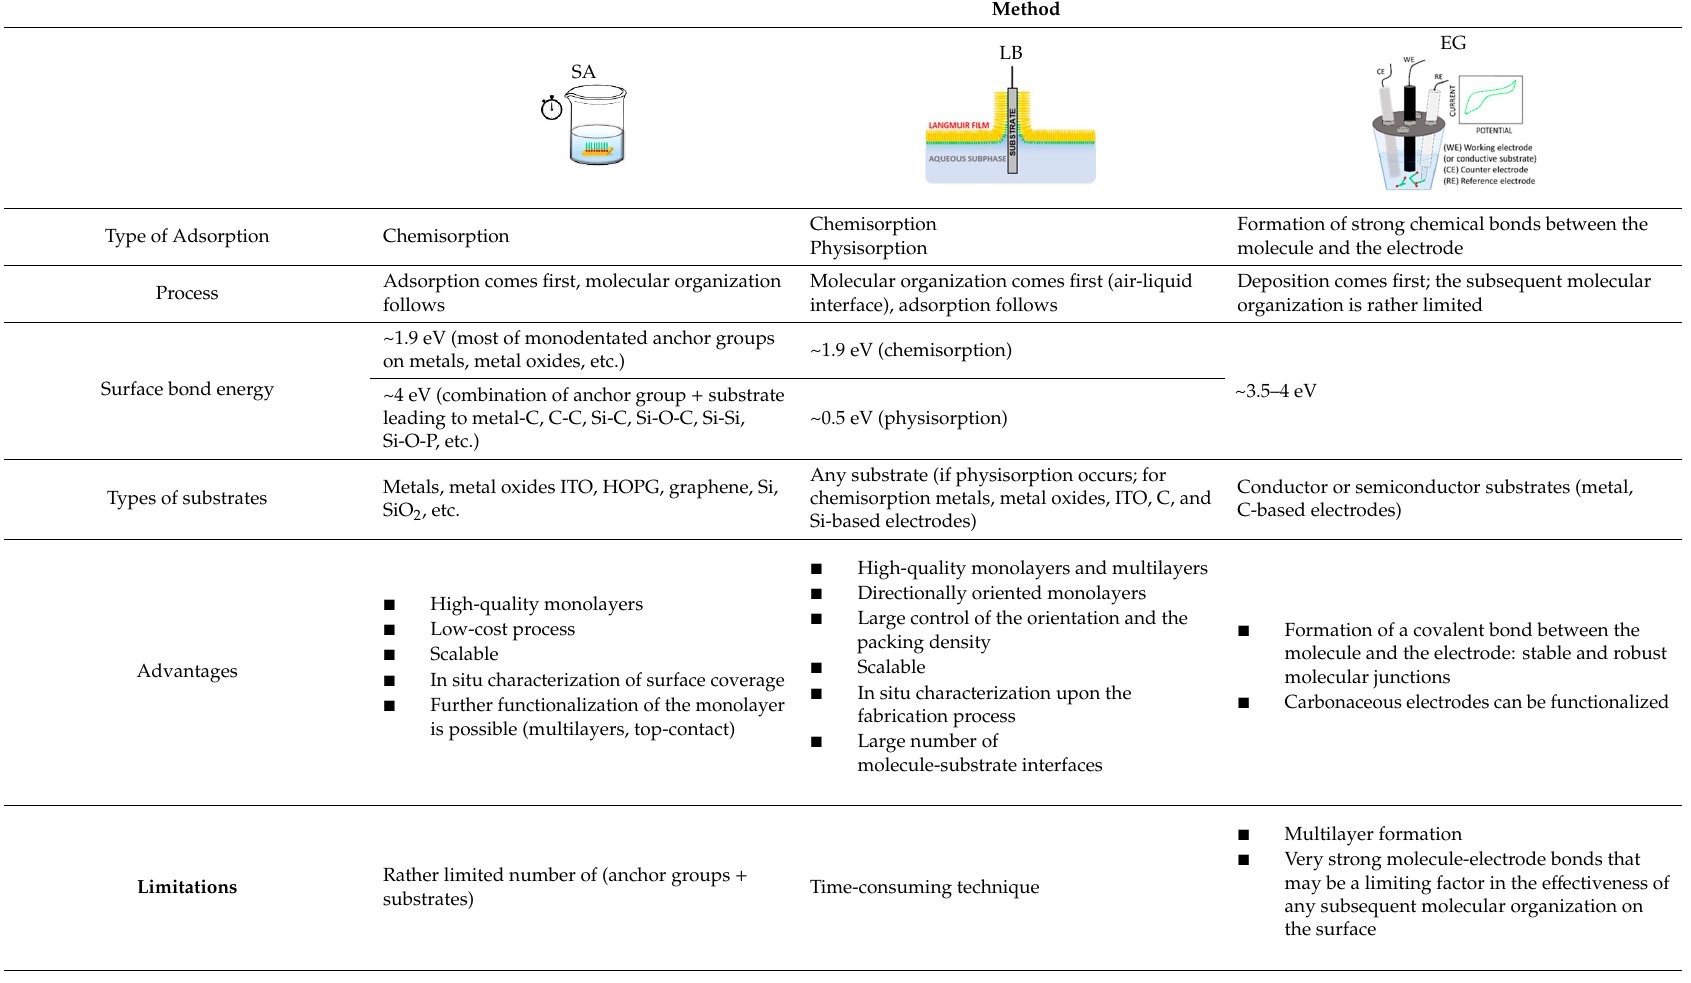
Table 2. Comparison of the deposition techniques to fabricate molecular films.